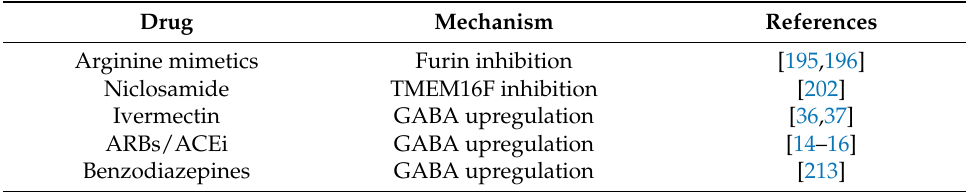
Table 1. Potential syncytia-inhibiting drugs and mechanisms of action.